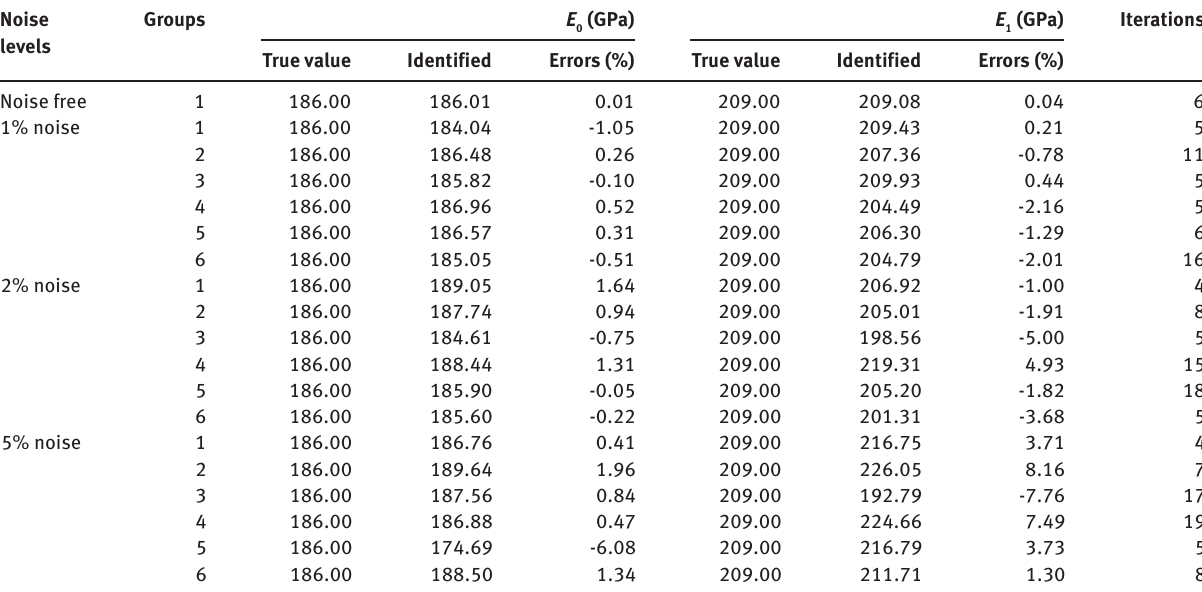
Table 13: Identified parameters of a rectangular FGM plane structure with exponential material variation (case 2: initial value E = 313 E 1